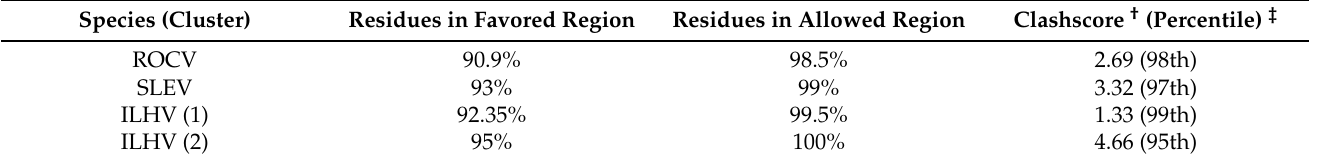
Table 4. Model quality analysis from MolProbity